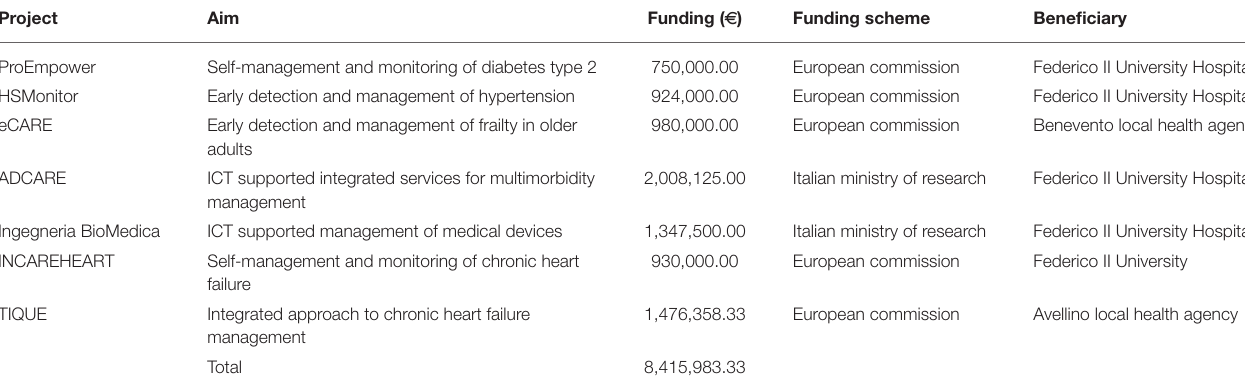
TABLE 3 | Pre-commercial procurements in